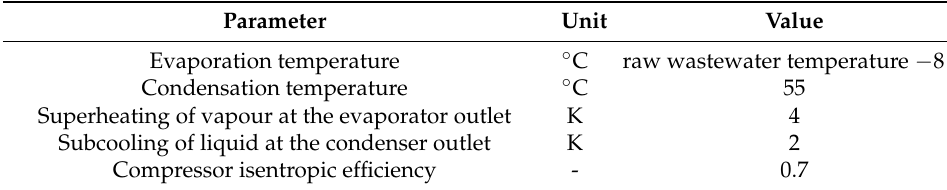
Table 2. Parameters for a single-stage heat pump cycle. Parameter Unit Value Evaporation temperature °C raw wastewater temperature − 8 K Condensation temperature °C 55 Superheating of vapour at the evaporator outlet K 4 Subcooling of liquid at the condenser outlet K 2 Compressor isentropic efficiency - 0.7 The results of thermodynamic simulations of heat pump cycles with different refrig-